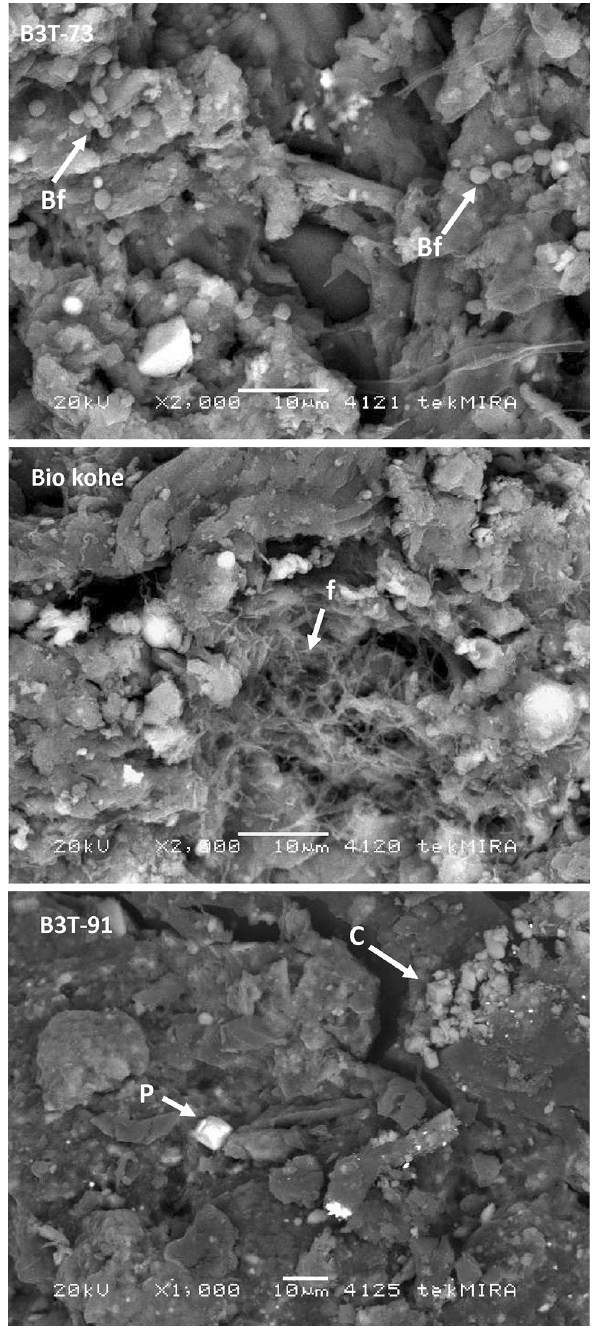
Fig. 6 Selected figure of SEM–EDS obtained from Bio Kohe, B3T– 73 and B3T–91 (C, calcite; Bf, Bacillus firmus ; P, pyrite; f, biomass